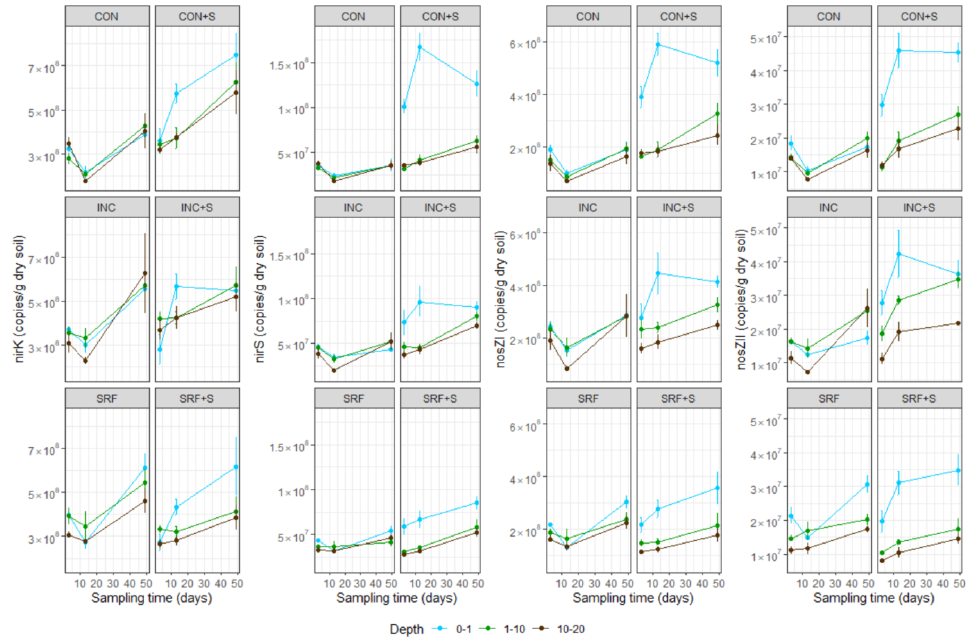
Figure 5. Dynamic of nirK , nirS , nosZI and nosZII gene abundance in CON (control), INC (straw incorporated in 0–10 cm soil layer) and SRF (straw applied at the soil surface) soil treatments in presence/absence of slurry (S) at three sampling depths (cm). Averages and standard errors of 4 replicates are shown.